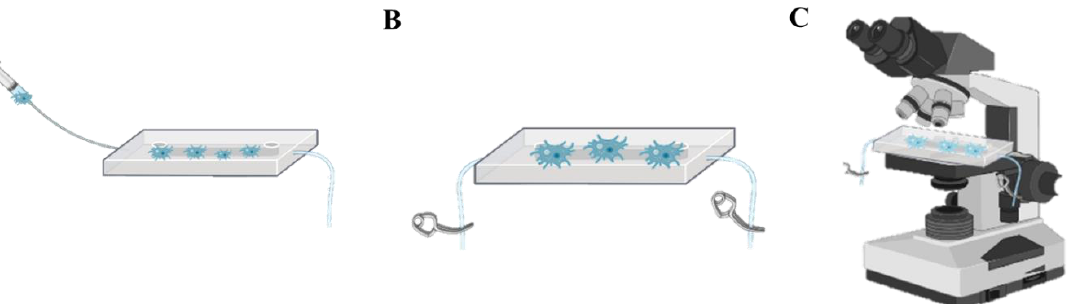
Figure 1. Schematic representation of flow cell apparatus. ( A ) Acanthamoebae are added to the flow cell apparatus. ( B ) Once amoebae have filled the flow cell, the ports are clamped to prevent further fluidic movement. ( C ) The flow cell is attached to the microscope stage for the duration of the experiment to prevent physical interference with Acanthamoeba motility.